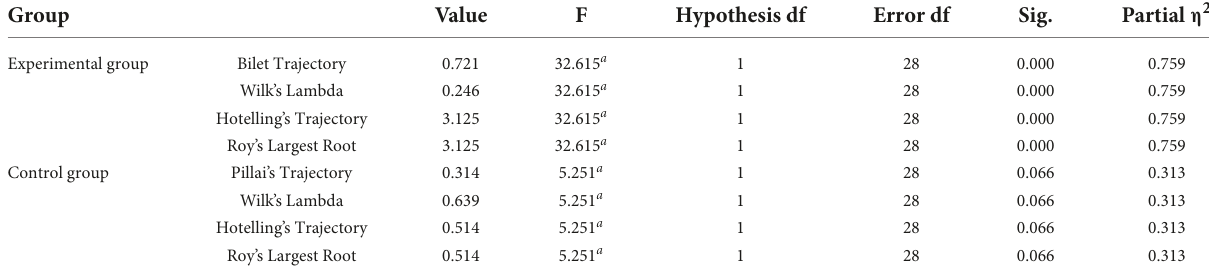
TABLE 10 Simple effect analysis table of ATEC score measure times. Group